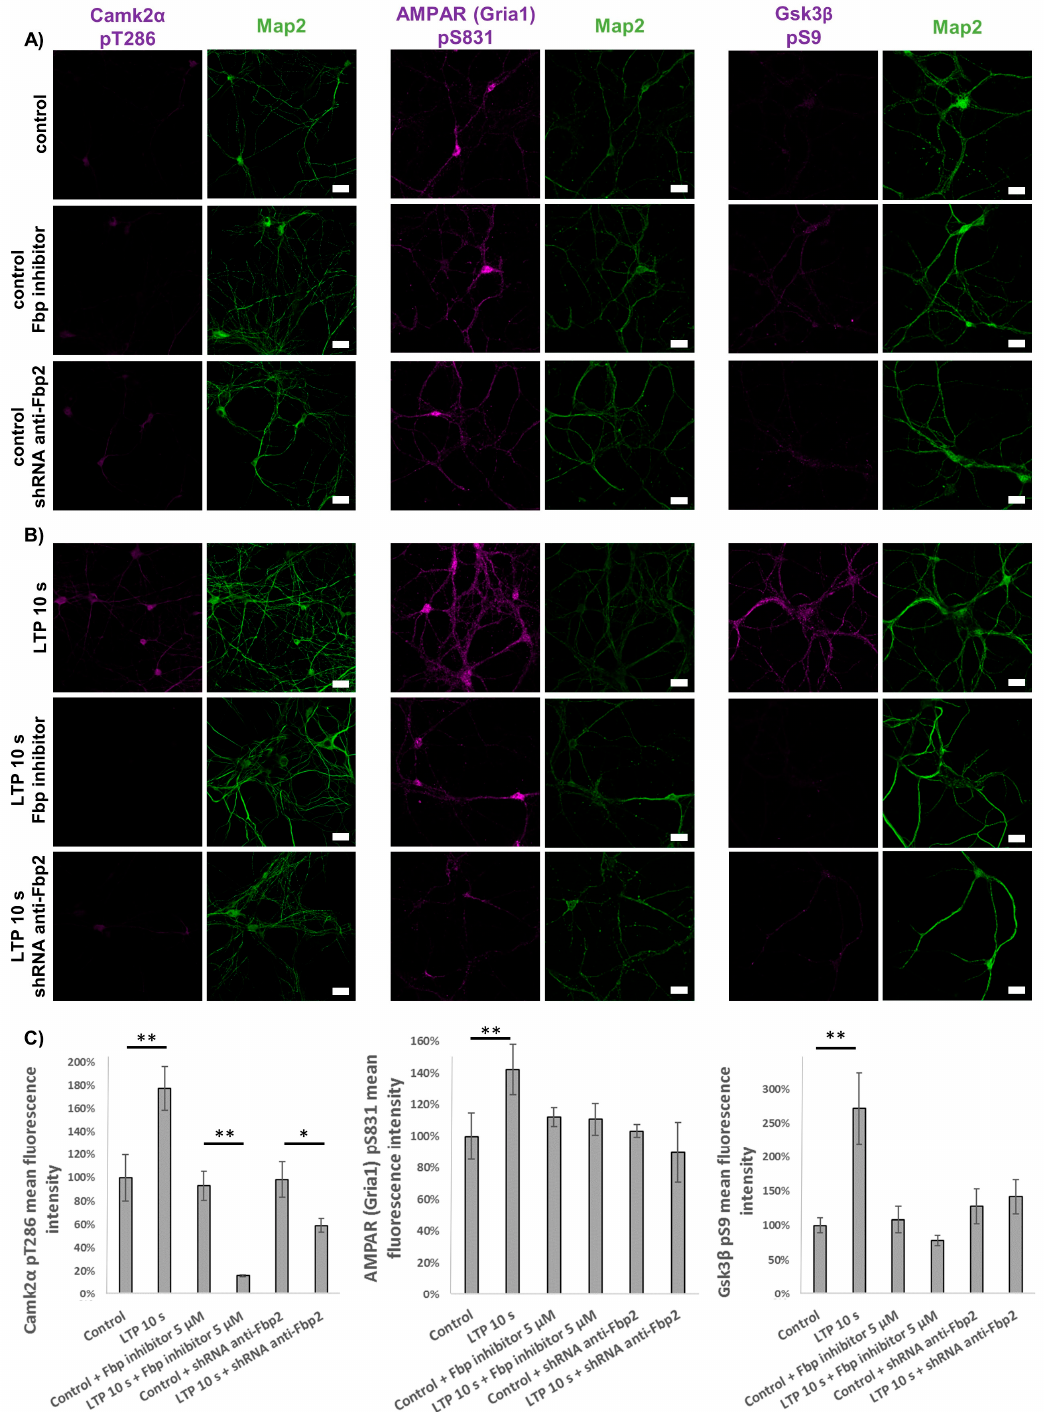
Figure 5. Silencing or inhibition / tetramerization of Fbp2 block expression of the early phase of LTP. ( A ) Fluorescence signals associated with phosphorylated forms of Camk2 α , AMPAR (Gria1) and Gsk3 β are not a ff ected by Fbp2 silencing or inhibition / tetramerization in neurons in which LTP was not induced. ( B ) Induction of LTP stimulates phosphorylation of Camk2 α , AMPAR and Gsk3 β (upper row) but manipulation with Fbp2 amount and structure strongly reduces the phosphorylation. ( C ) Quantification of the fluorescence associated with phosphorylated forms of Camk2 α (pT286), AMPAR (pS831) and Gsk3 β (pS9) as compared to the fluorescence recorded in unstimulated neurons (controls). Bar = 20 µ m. For each condition, N = 25 ROIs. The values are given as a mean and SD. * indicates p < 0.05, ** indicates p <